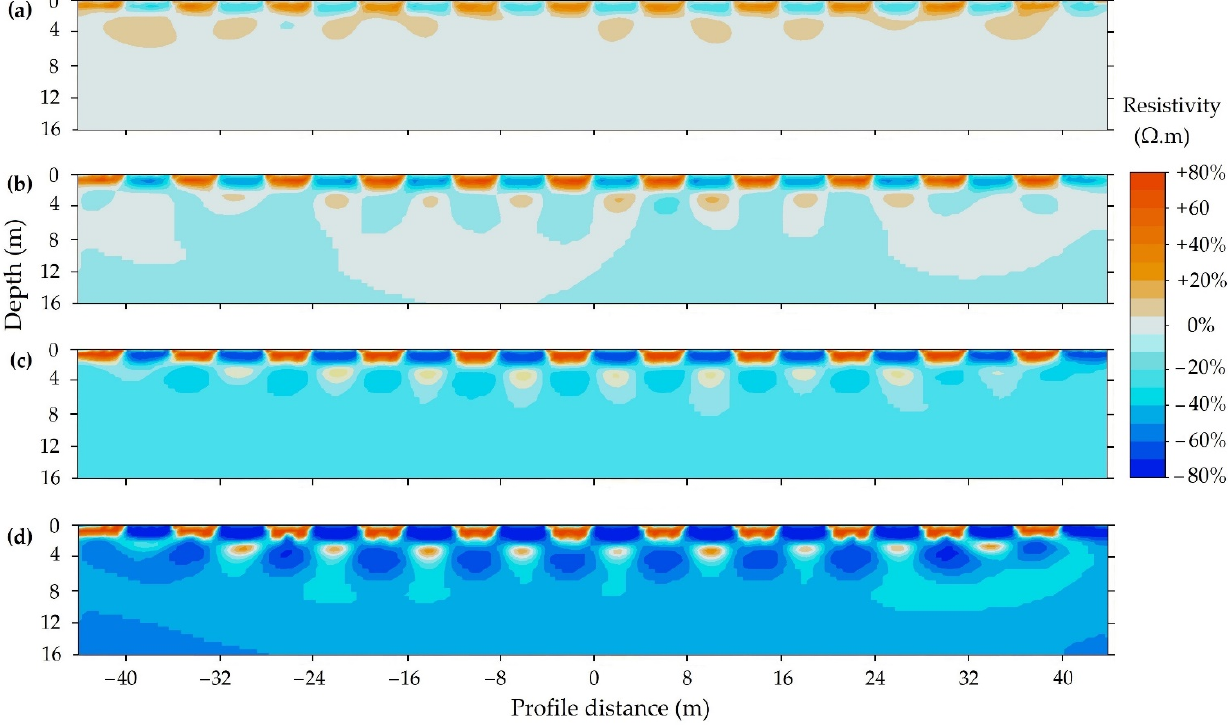
Figure 28. Wenner–Schlumberger (WS) array sensitivity to resistivity perturbations. The inverted model for: ( a ) ±